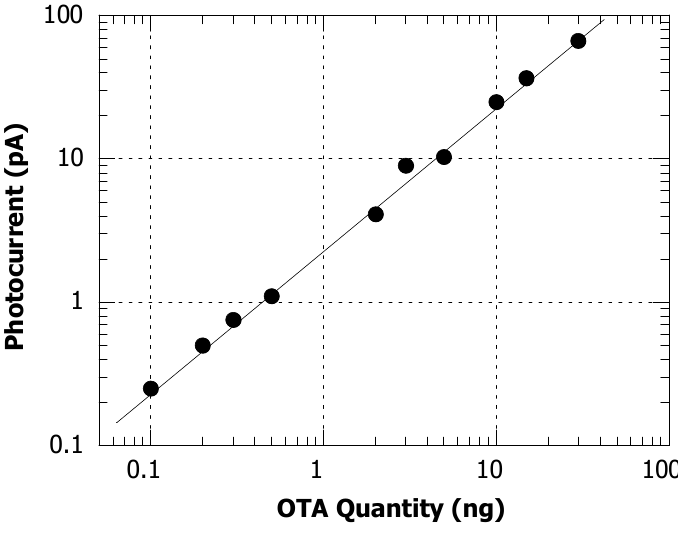
Figure 3 . Detection system response as a function of the OTA quantity. The 1-slope solid line is a guide for the eye. A minimum detectable signal of 0.1 ng has been